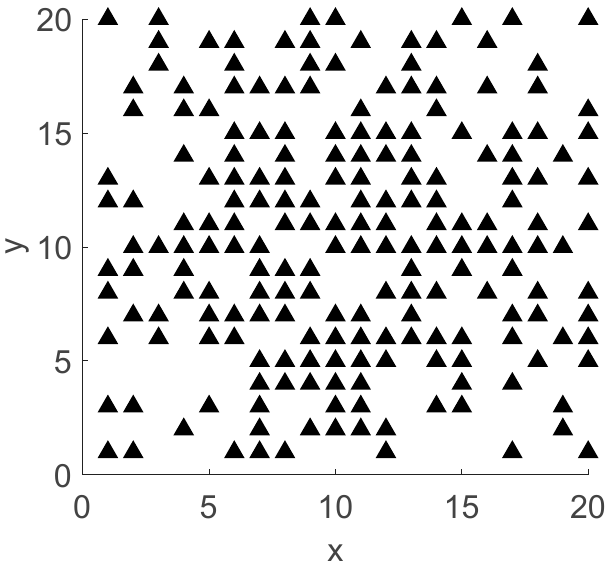
Figure 5. The array elements’ distribution of an optimized array using the DPSO-HSS algorithm.